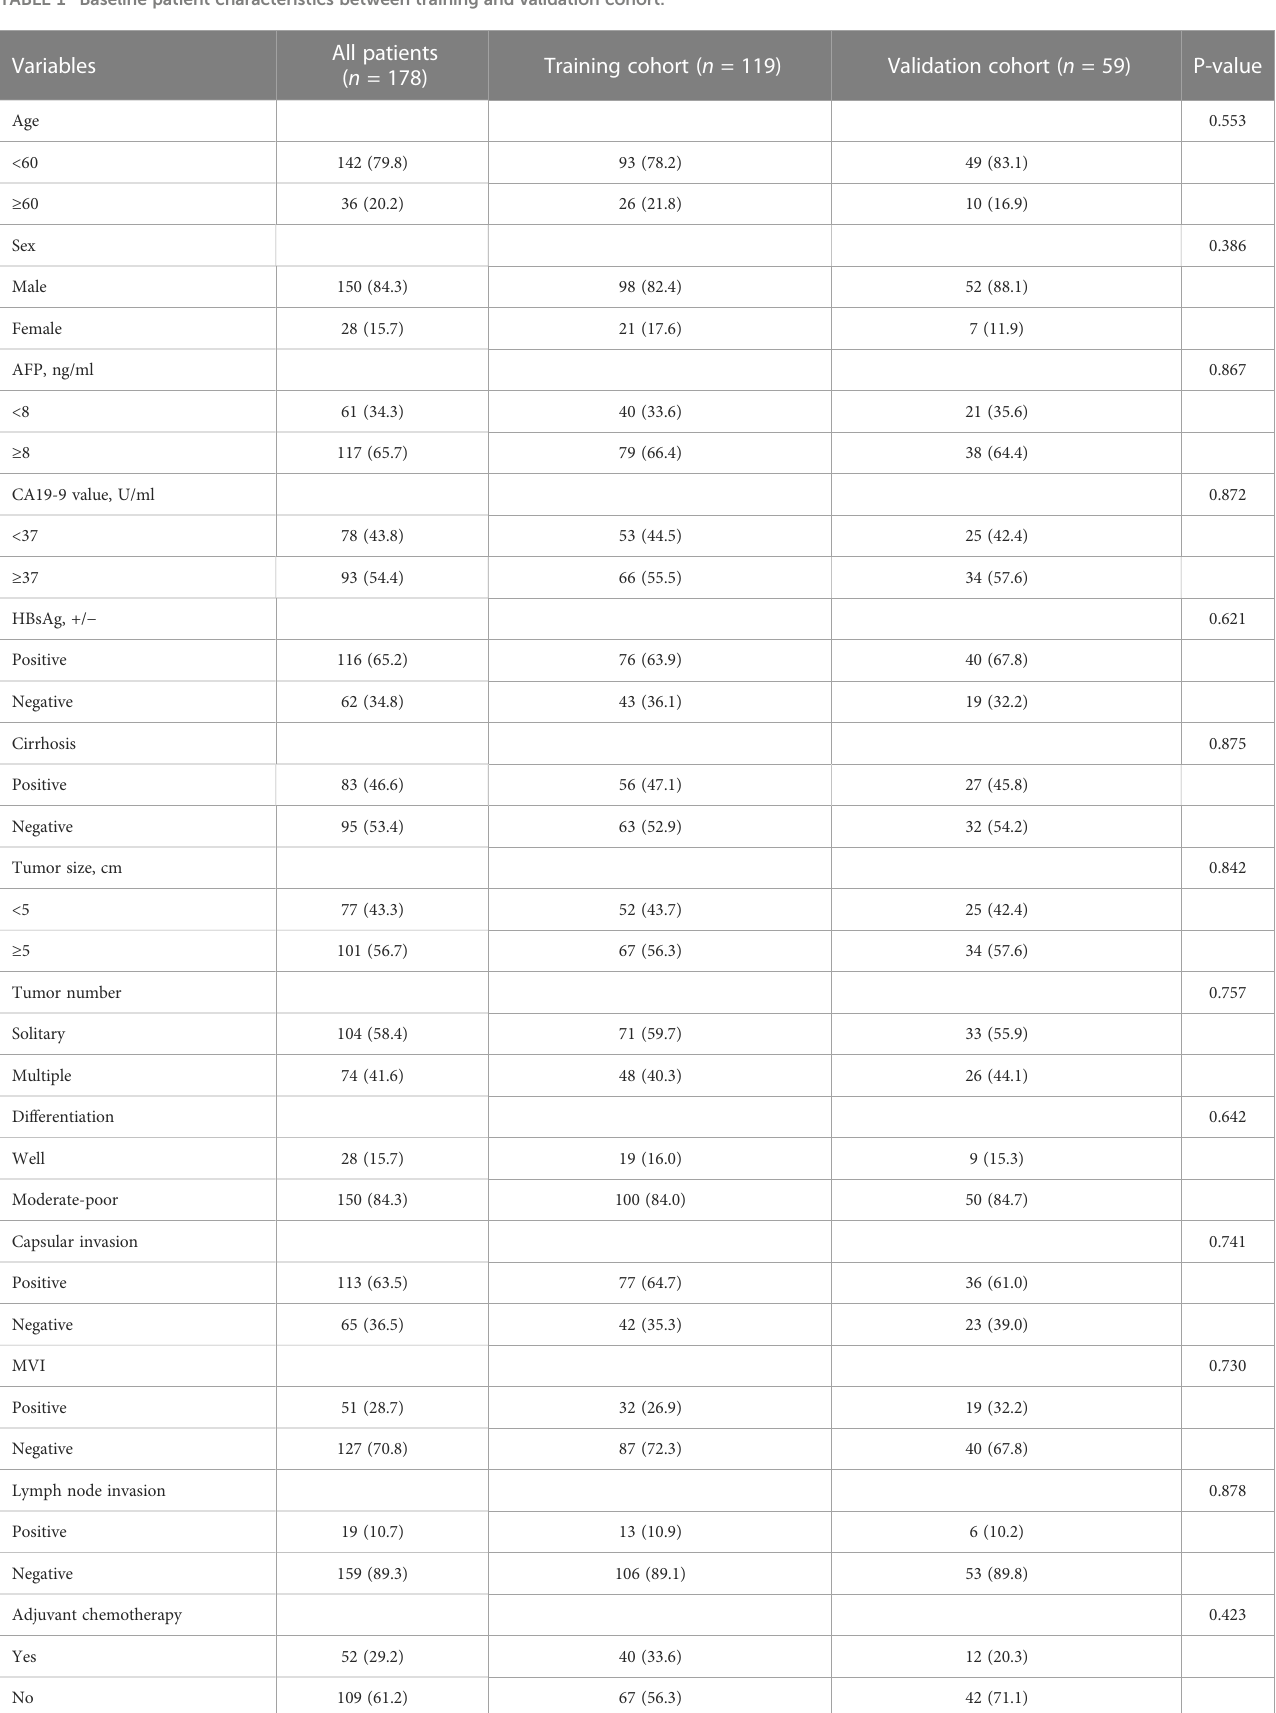
TABLE 1 Baseline patient characteristics between training and validation